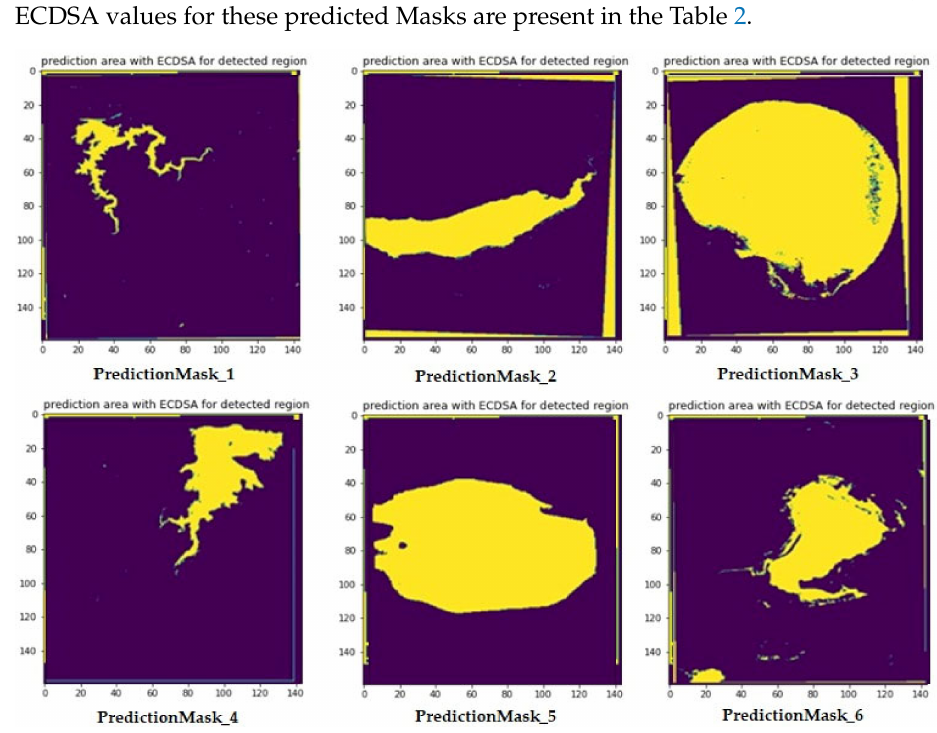
Figure 11. Predicted Masks for different Water bodies satellite